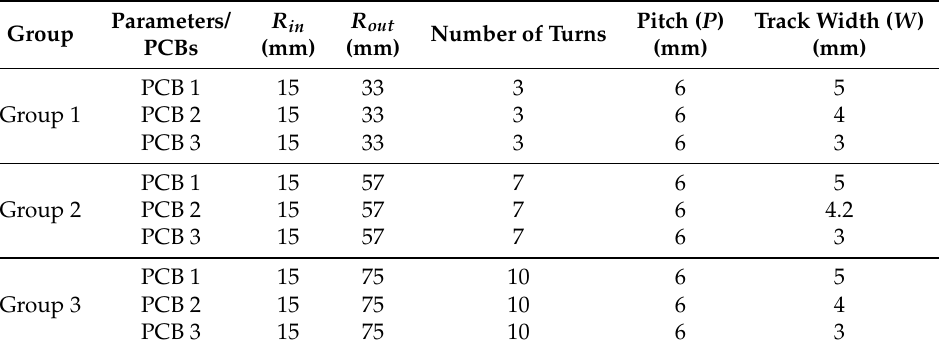
Table 5. Dimensional parameters of PCB prototypes.